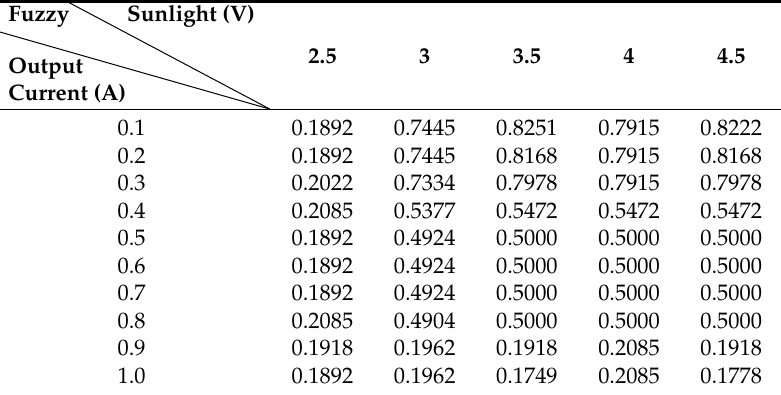
Table 5. Results of fuzzy test.